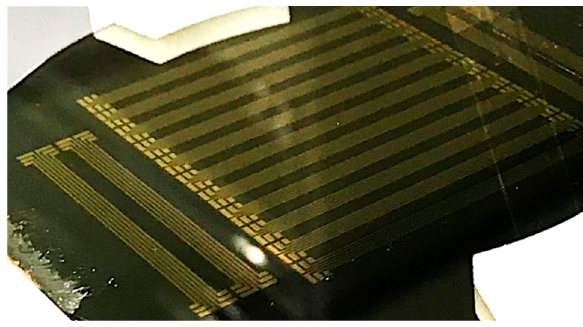
Figure 4. Test samples fabricated on 4-inch silicon substrate.